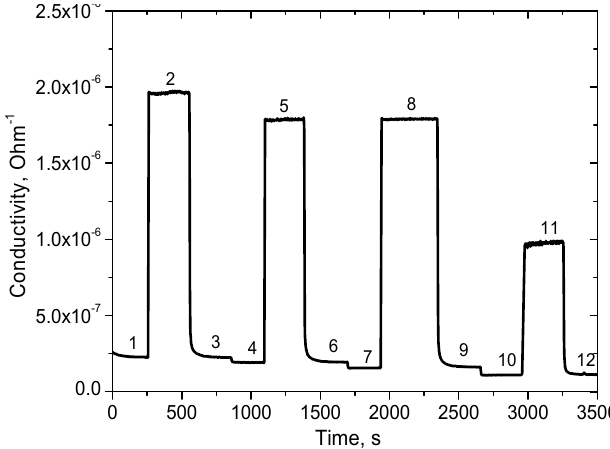
Figure 8. Sensor response to 100 ppm of hydrogen at different values of humidity: 1, air, RH80; 2, 100 ppm H 2 , RH80; 3, air, RH80; 4, air, RH60; 5, 100 ppm H 2 , RH60; 6, air, RH60; 7, air, RH40; 8, 100 ppm H 2 , RH40; 9, air, RH40; 10, air, RH30; 11, 100 ppm H 2 , RH30; 12, air, RH30.